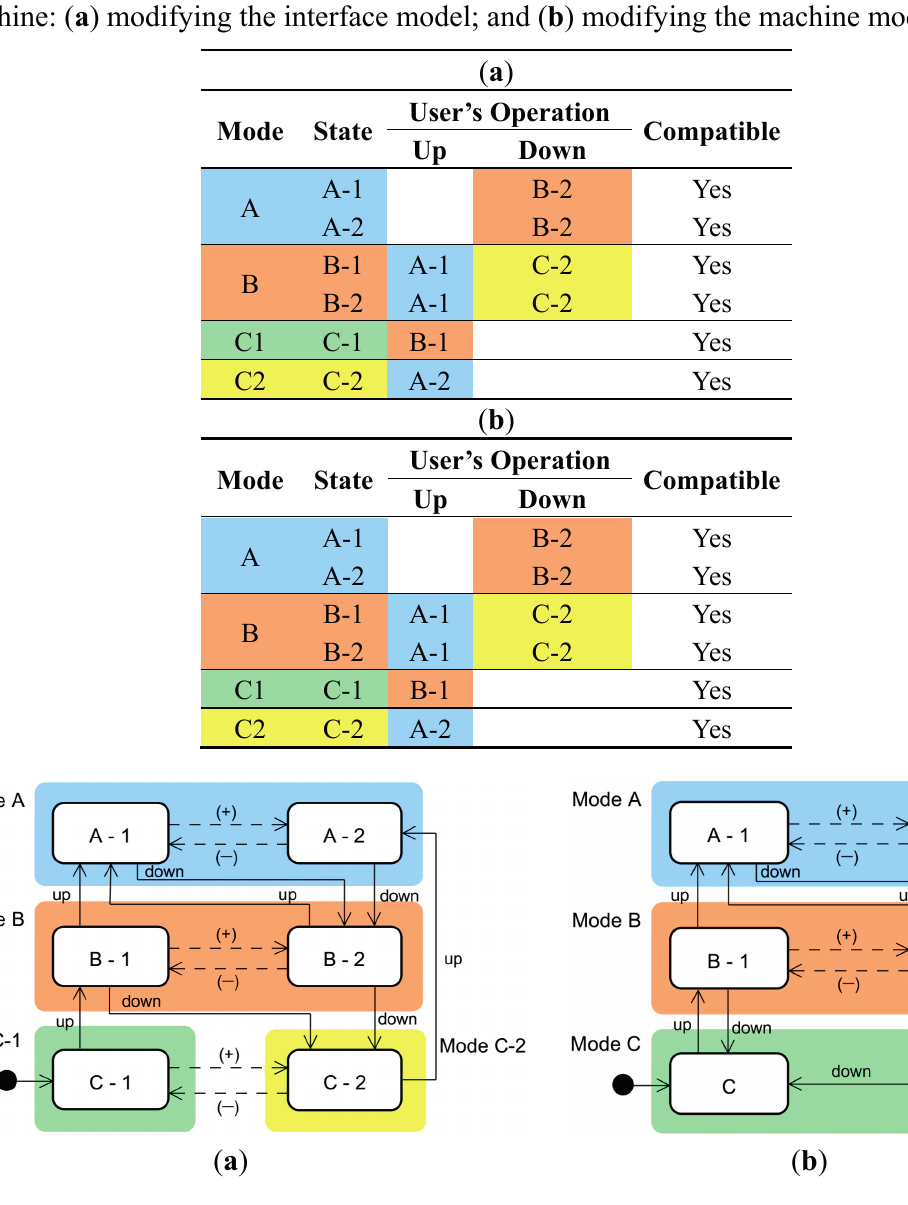
Figure 2. Two different approaches to modifying a user interface so that it satisfies the mode confusion criteria: ( a ) modifying the interface model; and ( b ) modifying the machine